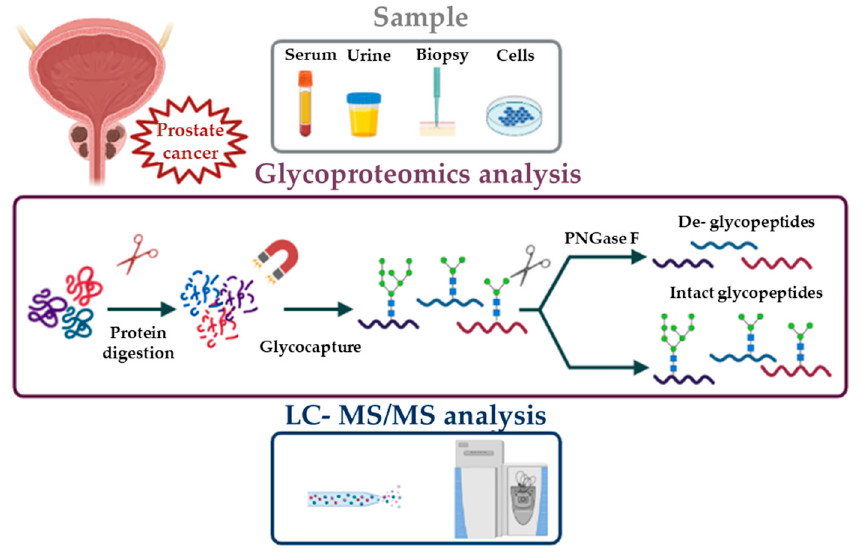
Figure 1. Bottom-up